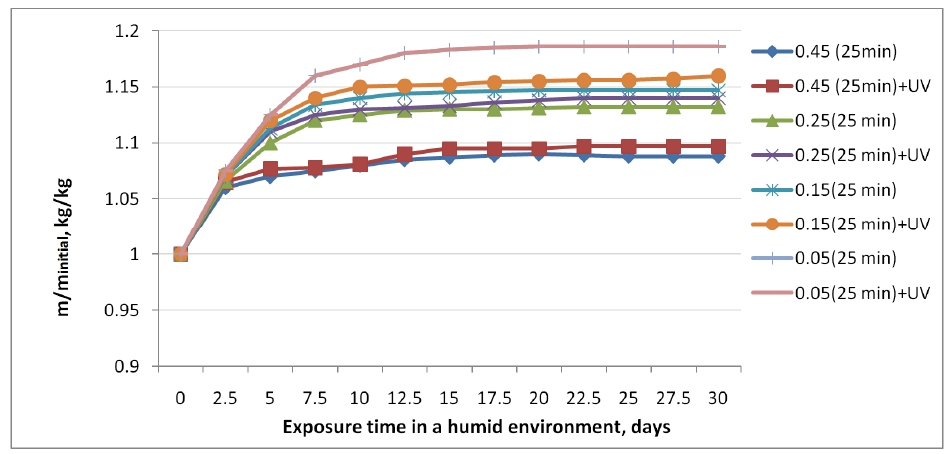
Figure 7. Kinetics of the relative mass of thermally modified pine specimens held in a humid